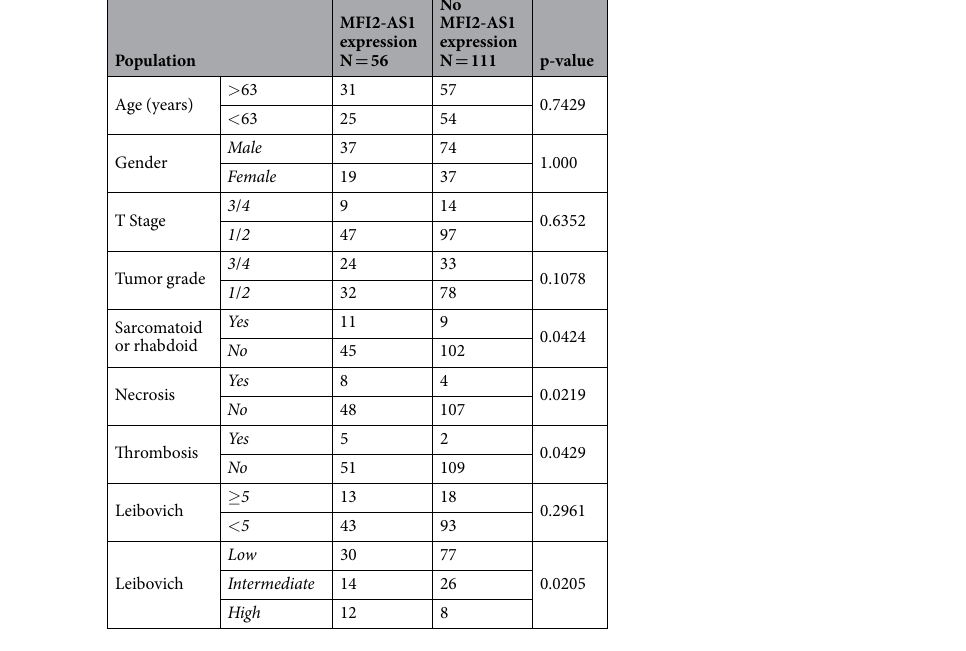
Table 3. Characteristics of the patients according to MFI2-AS1